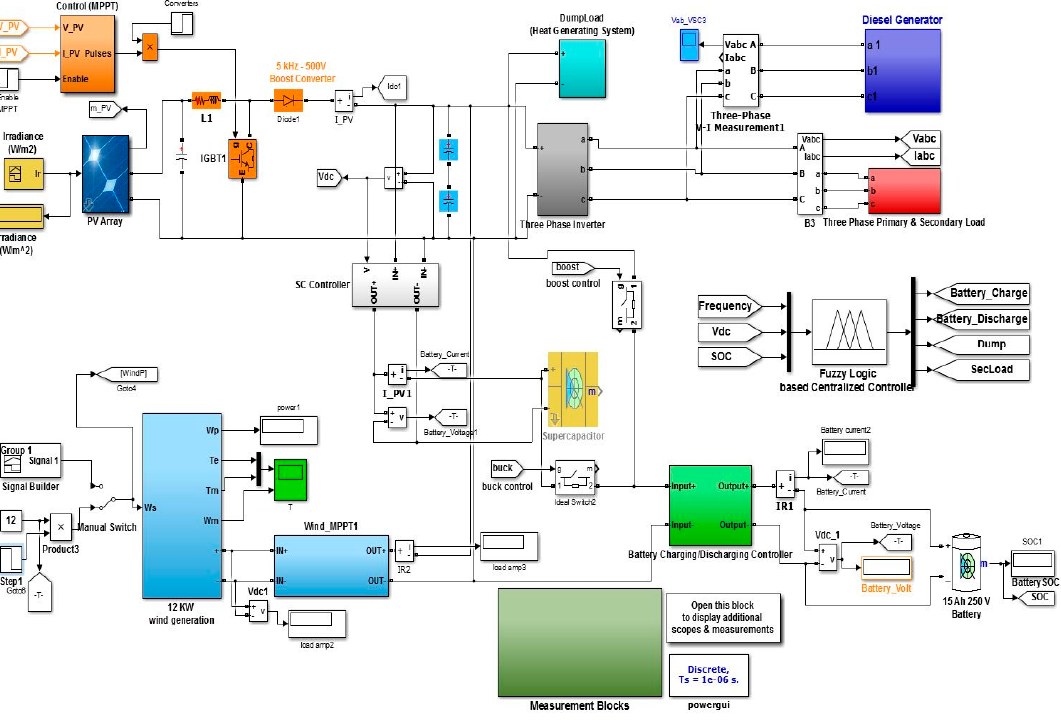
Figure 11 . Proposed system Simulink diagram. Figure 11. Proposed system Simulink